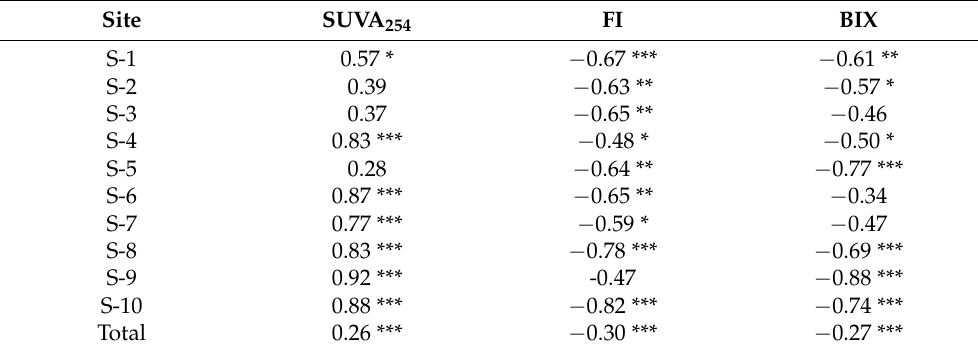
Table 5. The correlations of [Cu]/[DOC] ratios with optical characteristics for total and individual site combined size-fractioned AEOM solutions. Site SUVA